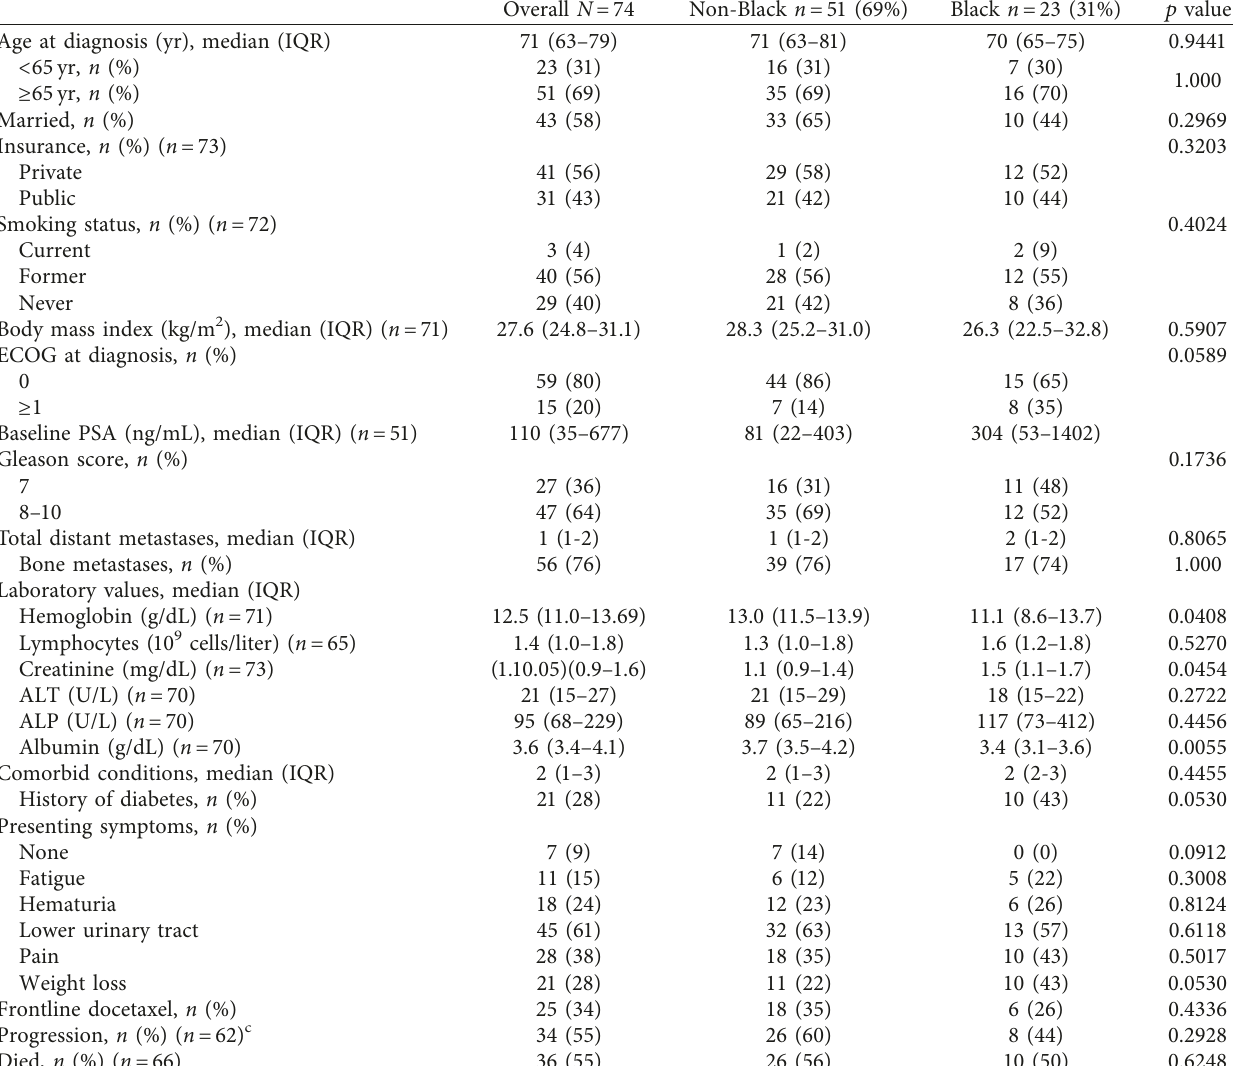
Table 1: Clinical features in Black versus non-Black men with hormone-sensitive metastatic prostate cancer ab